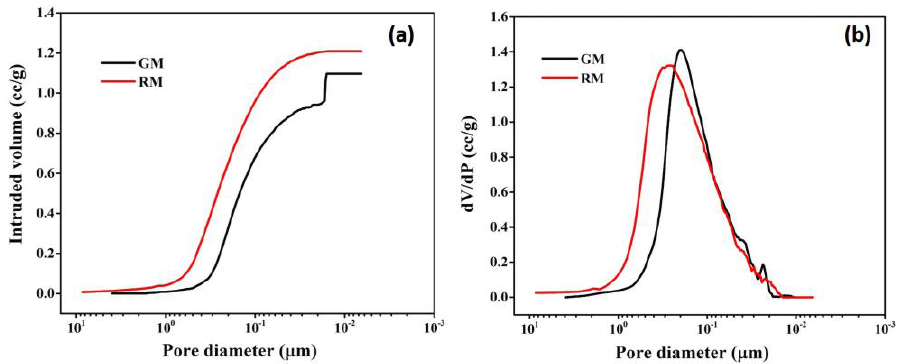
Figure 9. Pore size characterization: ( a ) mercury intrusion curve; ( b ) pore size distribution curve of resin and gel membrane using mercury porosimetry.